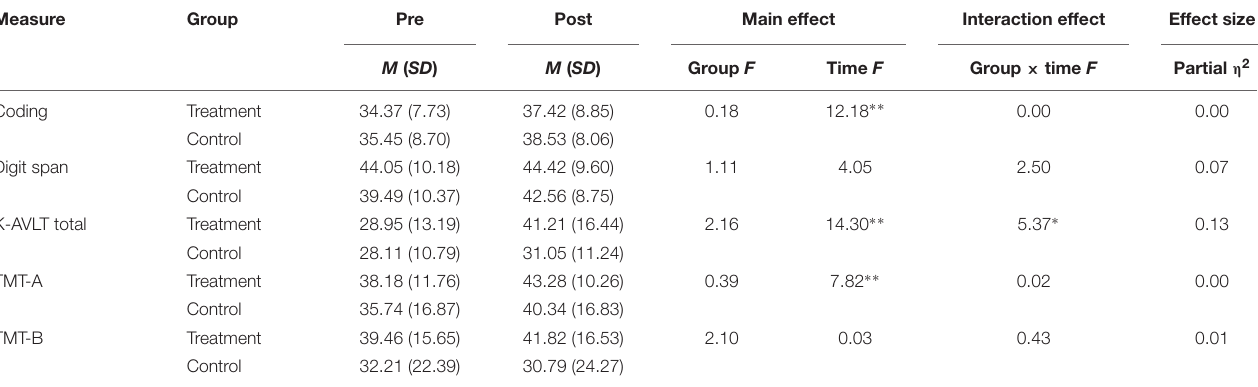
TABLE 3 | Effects of mBA on neurocognitive